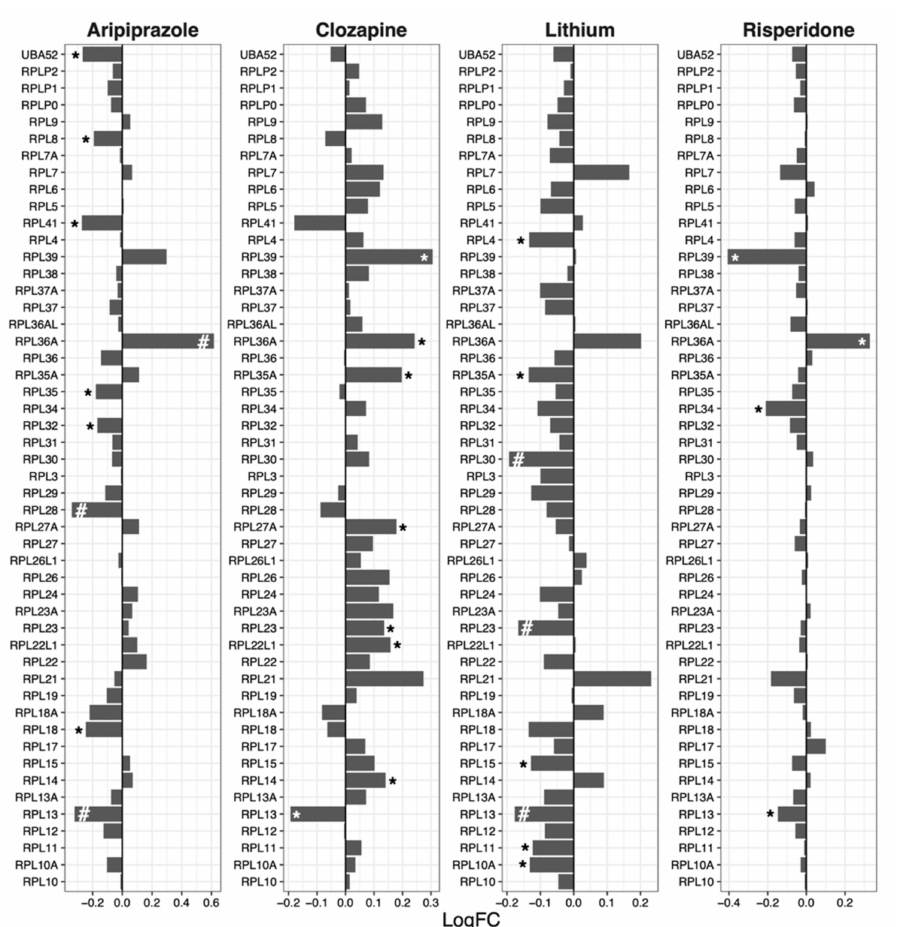
Figure 2. Effects of psychotropic drugs on the expression of genes encoding components of the ribosomal 60S subunit. FC = Fold change, * p < 0.05, # q < 0.05.